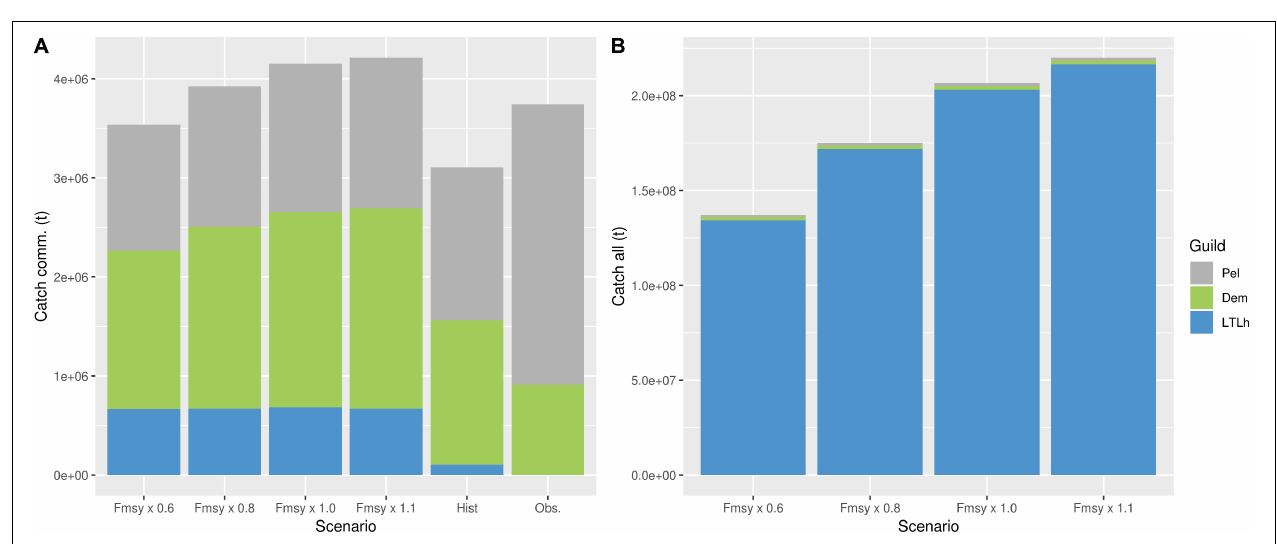
FIGURE 6 | (A) Simulated average total catches per year for the period 2055–2065 for the four scenarios (Fmsy × 0.6, Fmsy × 0.8, Fmsy × 1.0, and Fmsy × 1.1), simulated average total catches per year for the period 2005–2015 (Hist) and observed (Obs.). (B) Simulated average catches for the period 2055–2065 for the four scenarios including the additional components. Both figures show catches for the same guilds; pelagic (Pel - gray), demersal (Dem - green) and harvested lower trophic levels (LTLh - blue). Notice the difference in catch levels between panels (A) and (B) , and that lower trophic level is missing from the observed